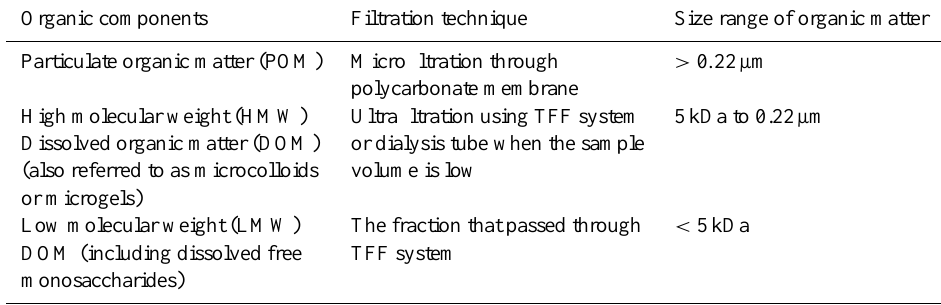
Table 1. Different fractions of organic matter obtained by